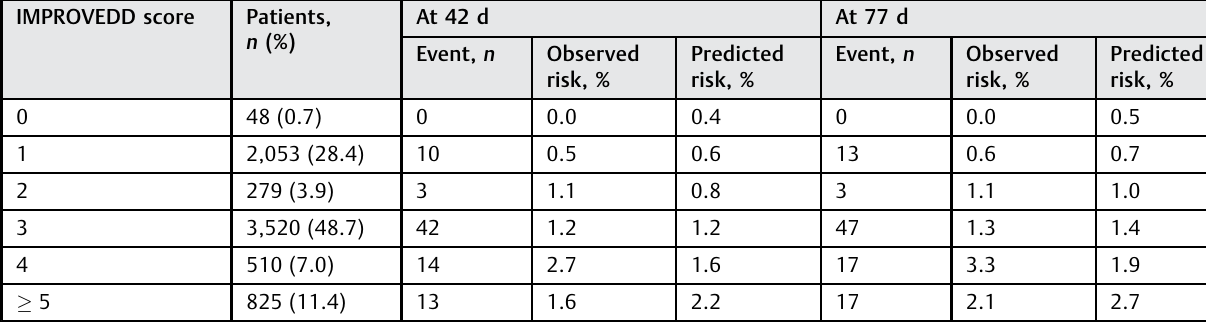
Table 6 Observed and predicted risk by the IMPROVEDD VTE risk score IMPROVEDD